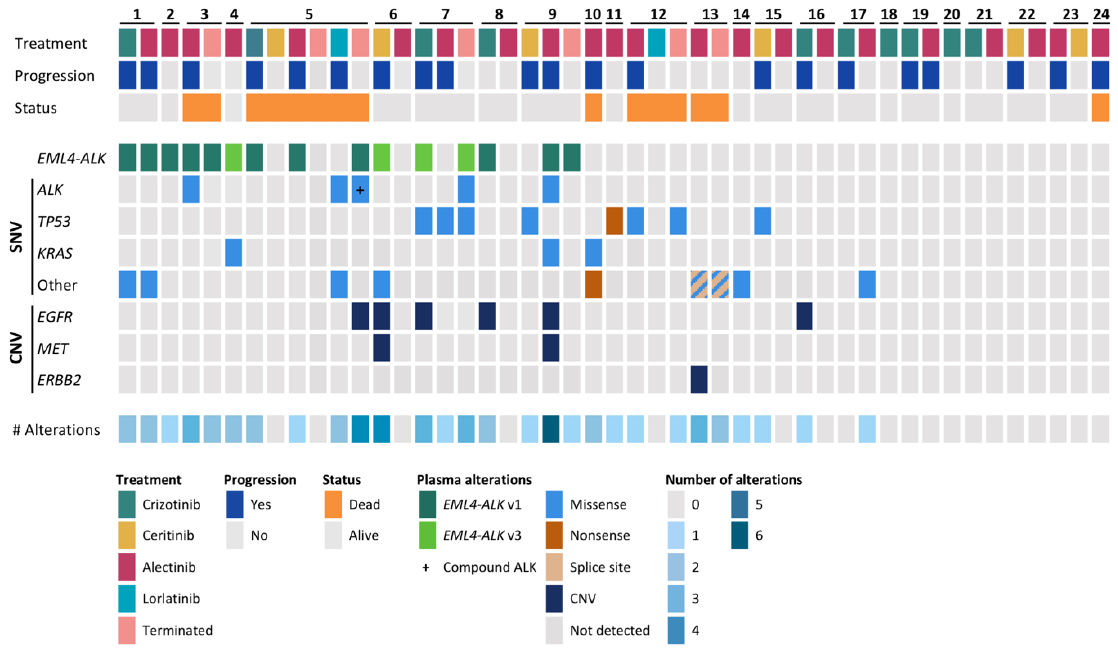
Figure 2. Overview of the basic characteristics and genomic alterations detected in circulating tumor DNA (ctDNA). The upper panel represents the treatment and outcome of the patients. The middle panel shows the alterations detected in ctDNA, pre-treatment or at treatment termination. The lower panel shows the number of alterations found in each sample. SNV, single-nucleotide variant; CNV, copy number variation; Terminated, sample taken at treatment termination due to progression or death.